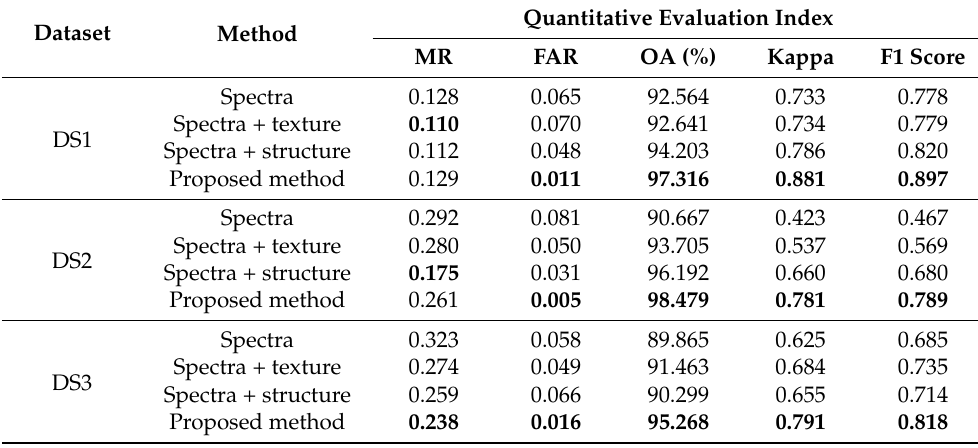
Table 4. Quantitative evaluation of change detection results in the third